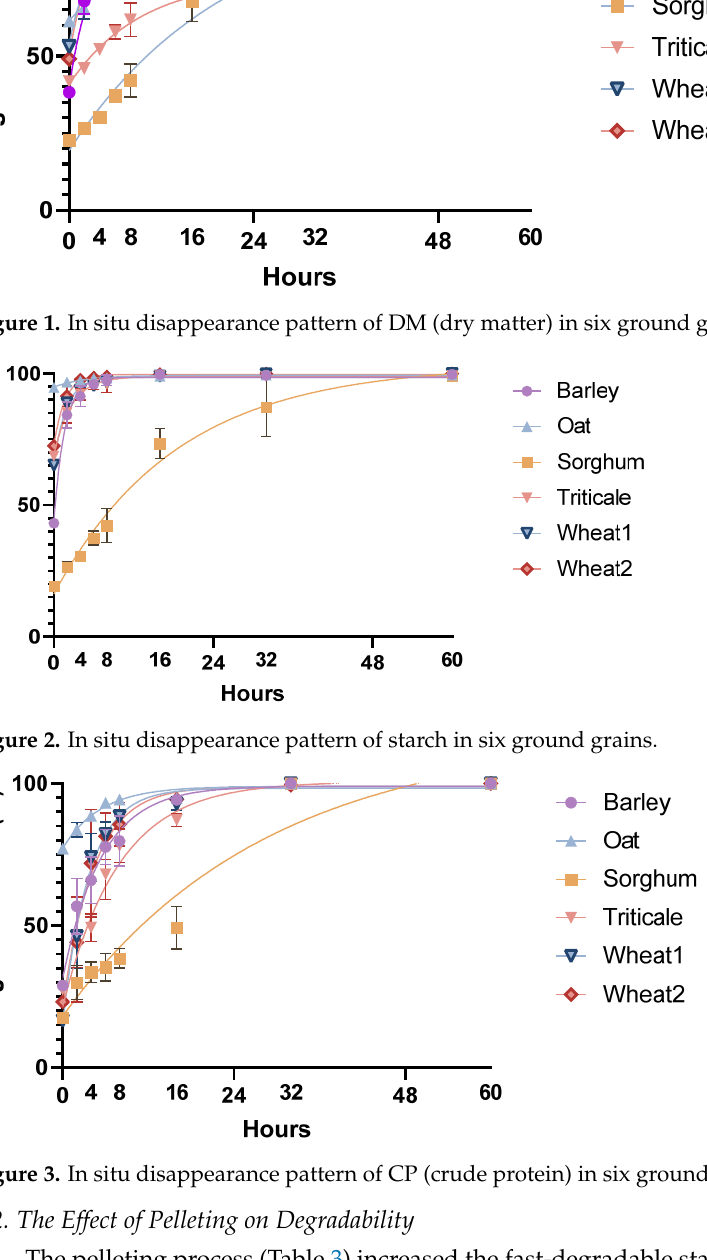
Table 3. The comparison of the rapidly degradable (a%) and the effective degradability (ED, %) between the ground and pelleted cereals.